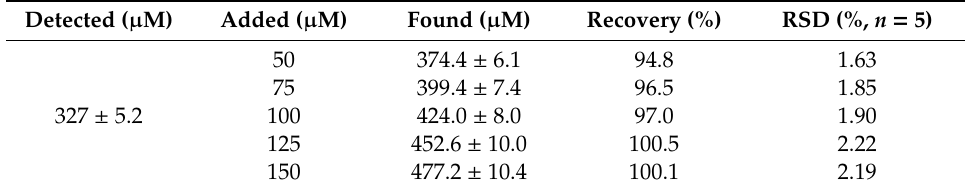
Table 4. Spiked recoveries of UA in pooled serum.